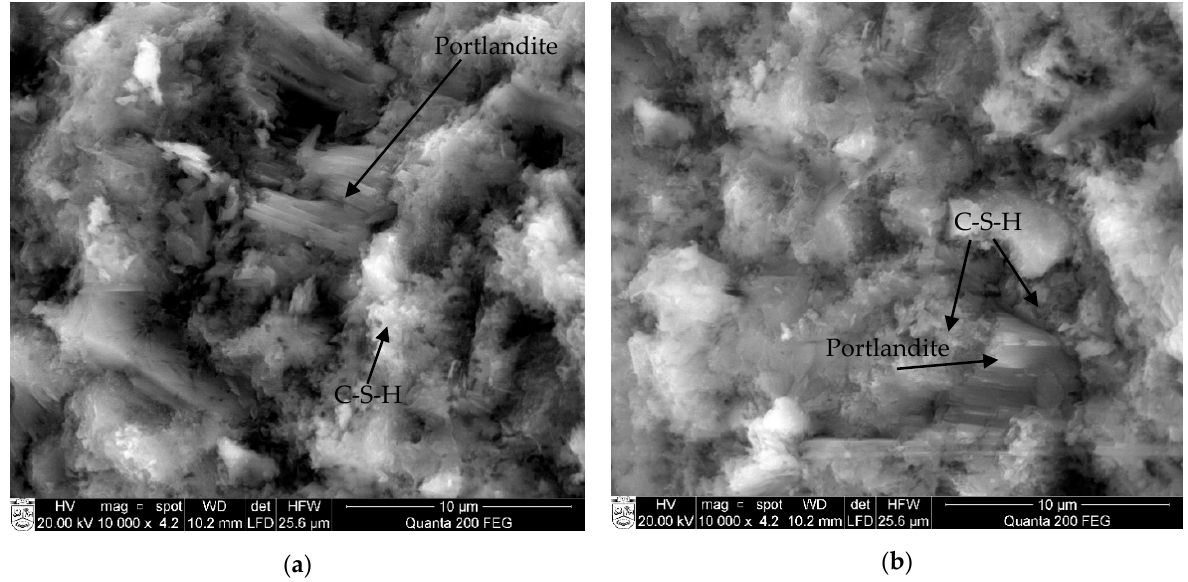
Figure 7. SEM images of hardened cement paste samples containing zeolitic by-product: ( a ) reference; ( b )